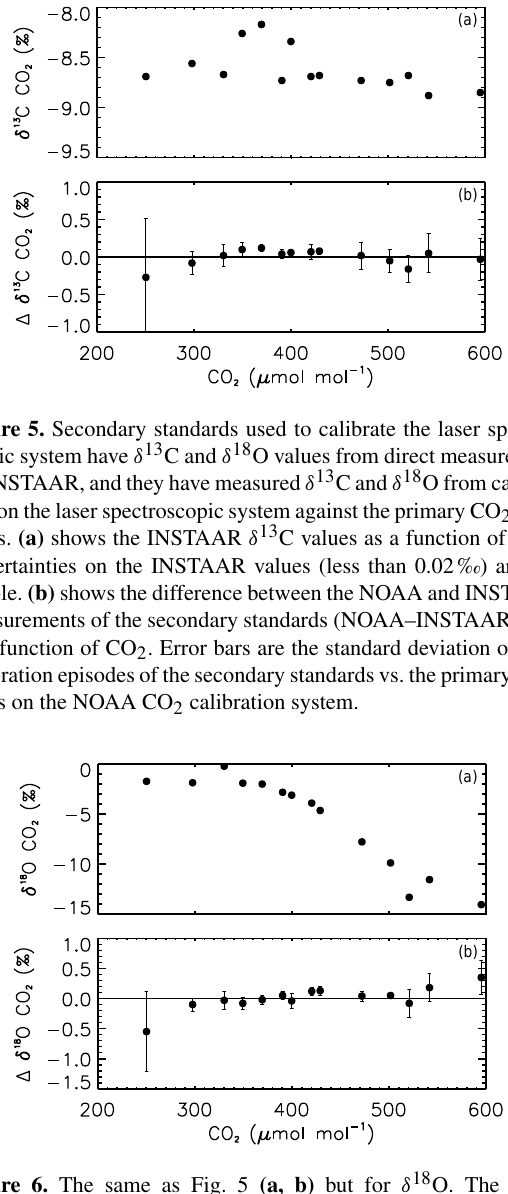
Figure 6. The same as Fig. 5 (a, b) but for δ 18 O. The CO 2 - dependent depletion of δ 18 O in cylinders above ambient CO 2 re- sults from the depleted δ 18 O of the spike